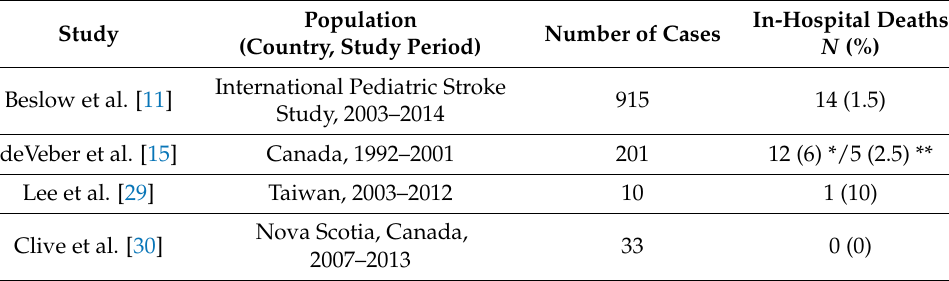
In-Hospital Deaths Number of Cases N (%)